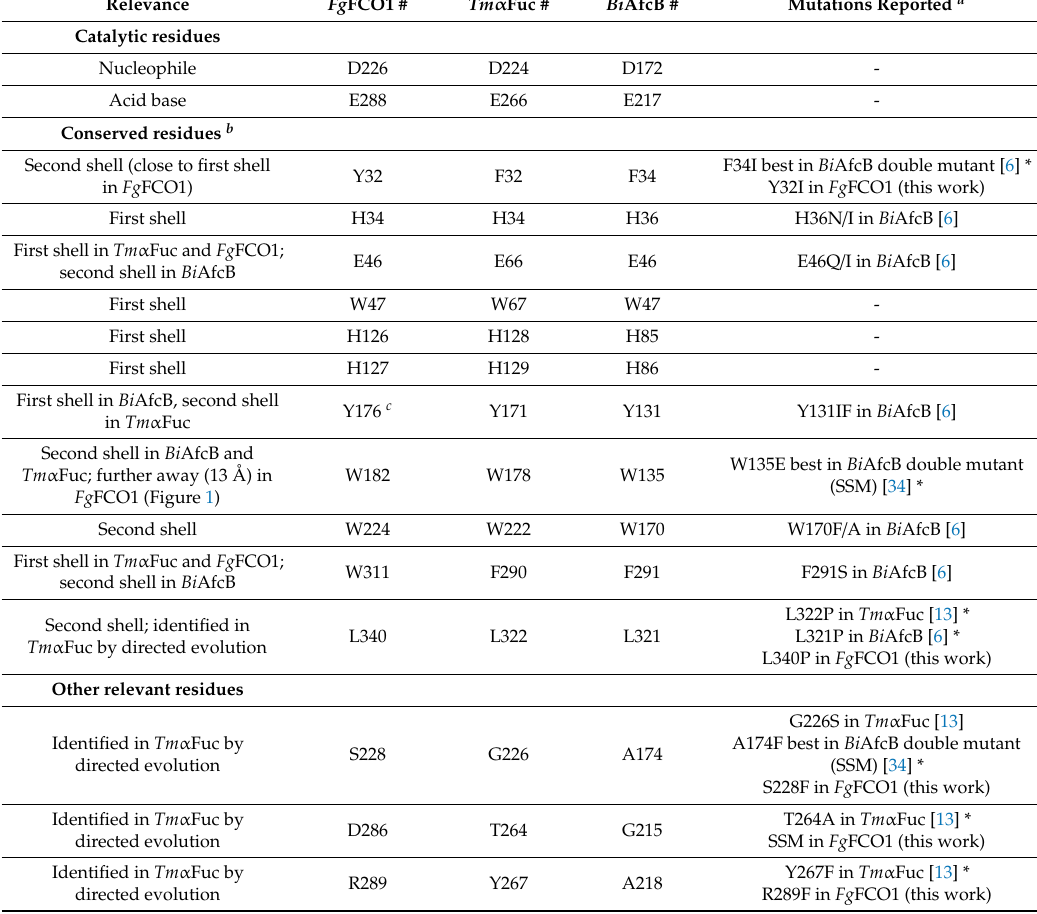
Table 1. Overview of catalytic residues, highly conserved residues, and other relevant amino acid residues and their respective numbering (#) in the three GH29 α - l -fucosidases discussed in this work: Tm α Fuc, Bi AfcB, and Fg FCO1 (the latter using numbering from the crystal structure [25]). The assignment of similar residues is generally deduced from sequence alignment, except for the area around the catalytic acid / base where sequence alignment is generally poor [36]; assignments here were guided by crystal structures (Figure S1). Mutations reported for each residue are included; an asterisk (*) designates mutations, which improved transglycosylation. Conserved residues were determined from multiple sequence alignment (Figure S1); all G and P residues are excluded as it is generally not advised to mutate these due to their involvement in protein folding